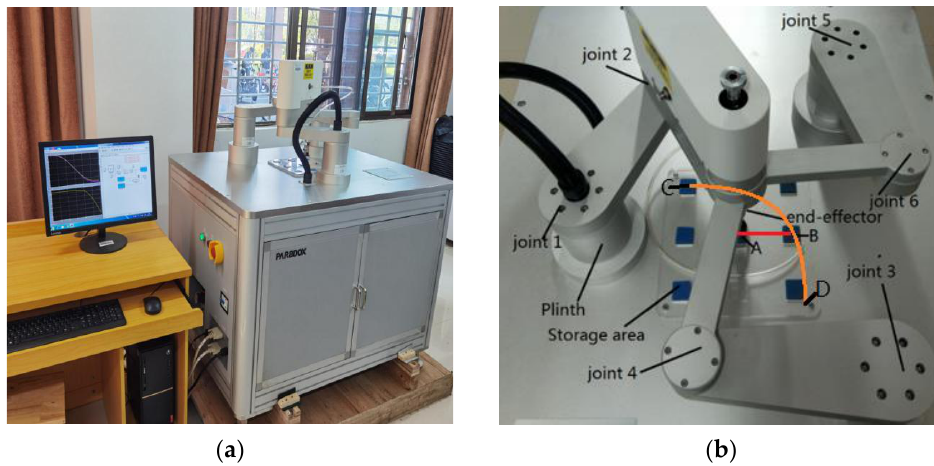
Figure 4. Experimental platform diagram of 4-DOF redundant parallel robot: ( a ) experimental platform and ( b ) top view of robot arm.